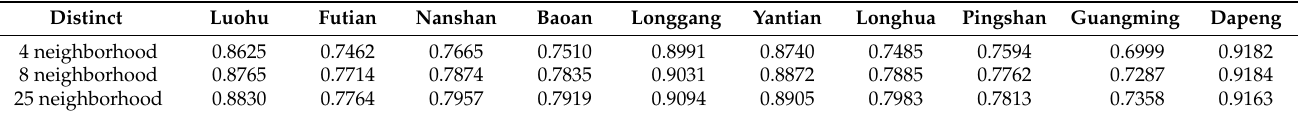
Figure 9. Land-use/land-cover prediction in Yantian District using different neighborhoods. Table 4. The overall classification accuracy of various districts in Shenzhen in different spatial neighborhoods. Distinct